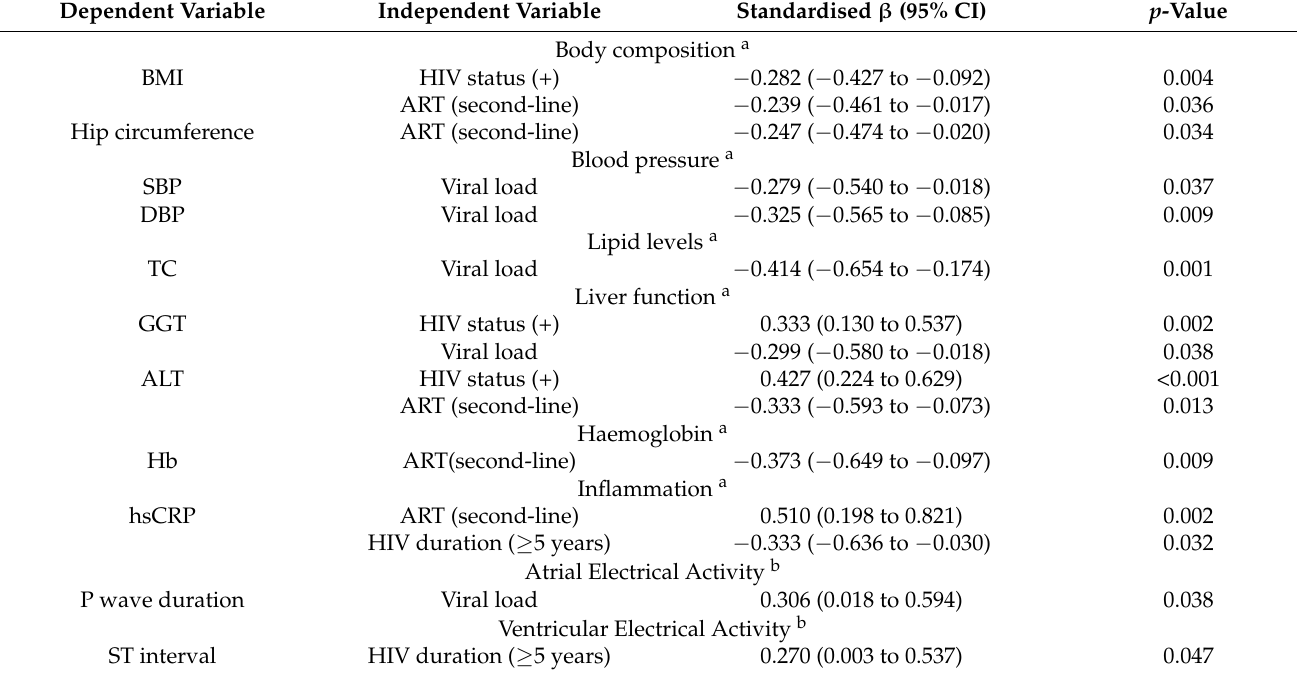
Table 4. Significant associations between HIV and cardiometabolic